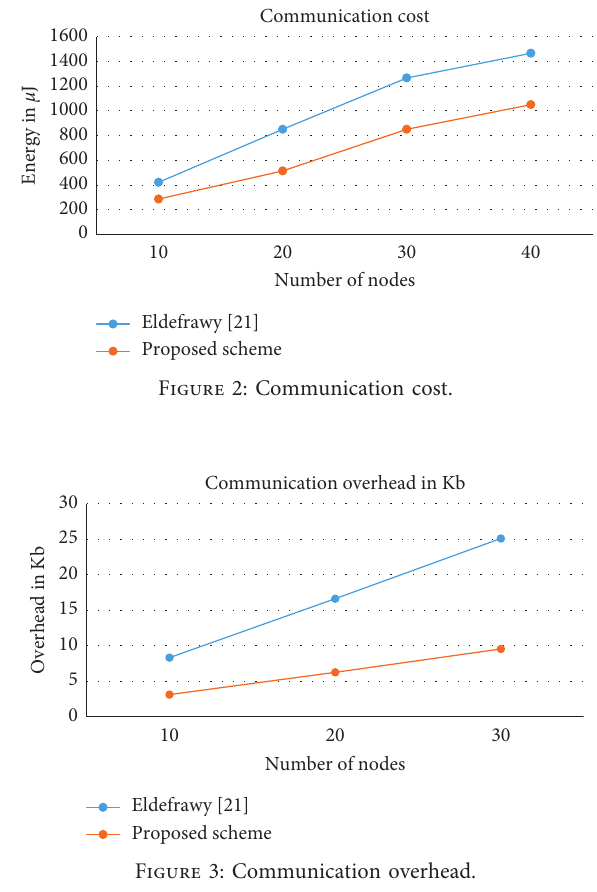
Figure 3: Communication